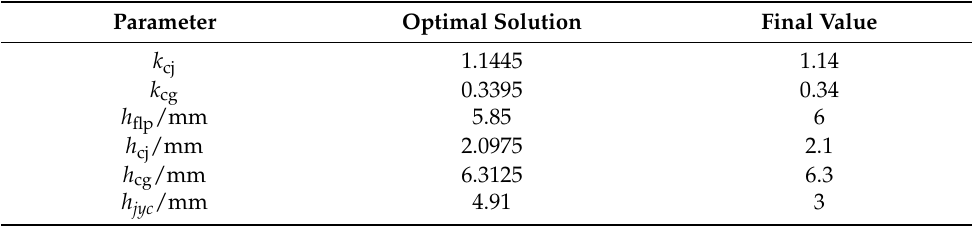
Table 4. The optimal solution and the final value of each response